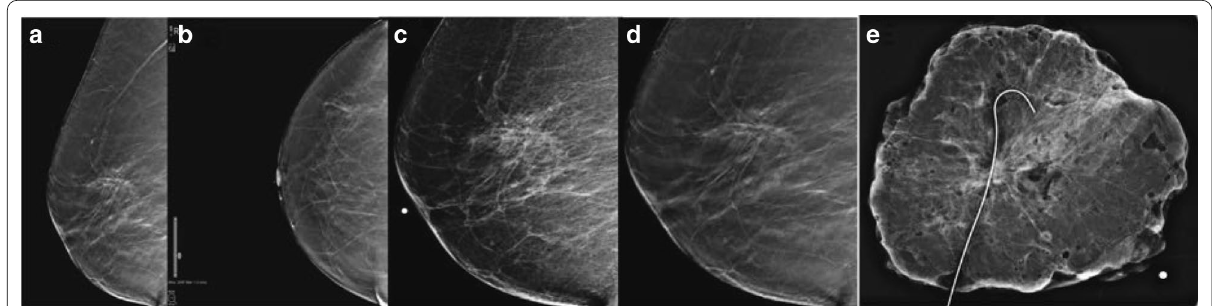
Fig. 1 Full‑field digital mammography ( a ) lateral medial oblique and ( b ) craniocaudal views and ( c , d ) 2D lateral focal spot compression and tomosynthesis showing a distortion in the upper outer quadrant, posterior third. e Surgical specimen; histology report confirmed atypical ductal hyperplasia with columnar cell changes and columnar cell hyperplasia